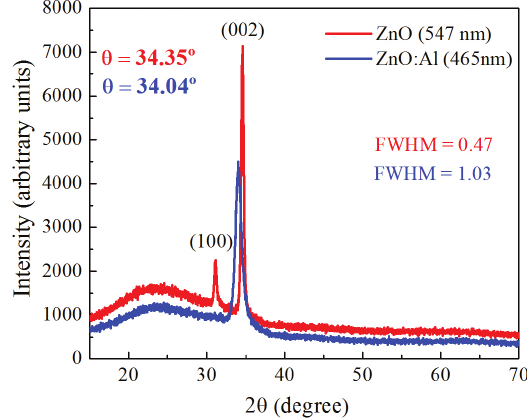
Figure 1. XRD spectra of intrinsic ZnO and ZnO:Al films deposited onto glass